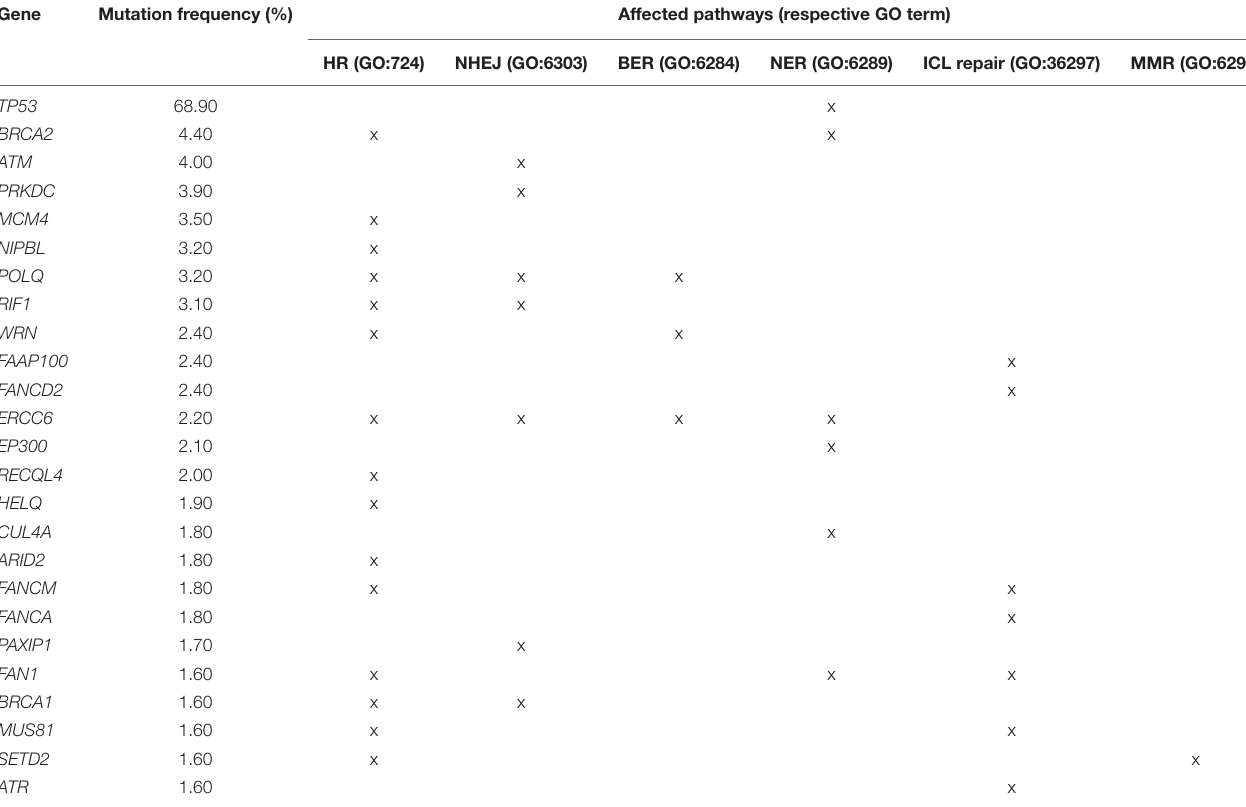
TABLE 1 | Prevalence of the top 25 most frequently found somatic DDR gene mutations and associated pathways in a cohort of 3706 PDAC patients. Gene Mutation frequency (%) Affected pathways (respective GO term) HR